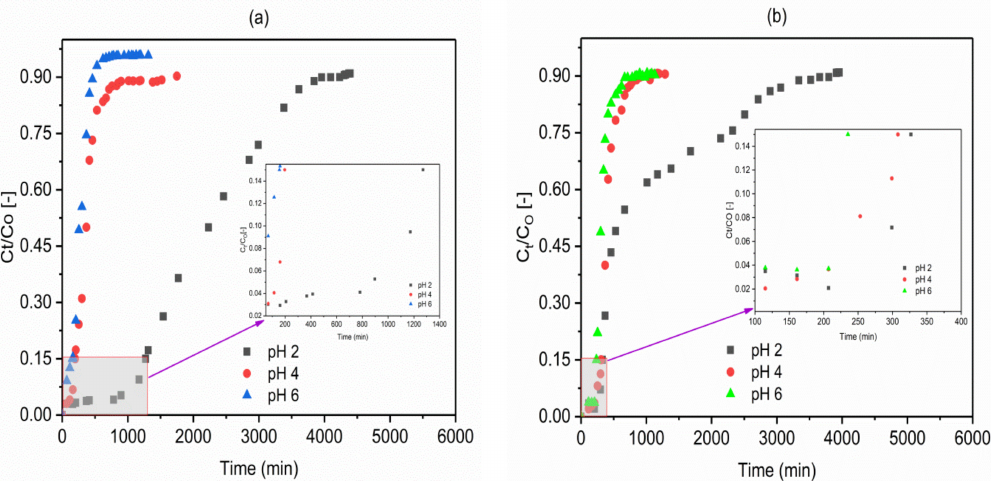
Figure 6. Effect of pH on the breakthrough behavior of fluoride in ( a ) VPum: 0.075–0.425 mm and ( b ) VSco: <0.075 mm (C O : 10 mg/L; Q O : 1.25 mL/min; bed depth 10